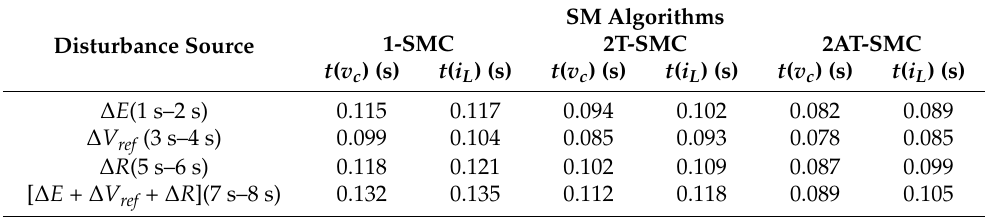
Table 6. Experimental comparisons of response time.